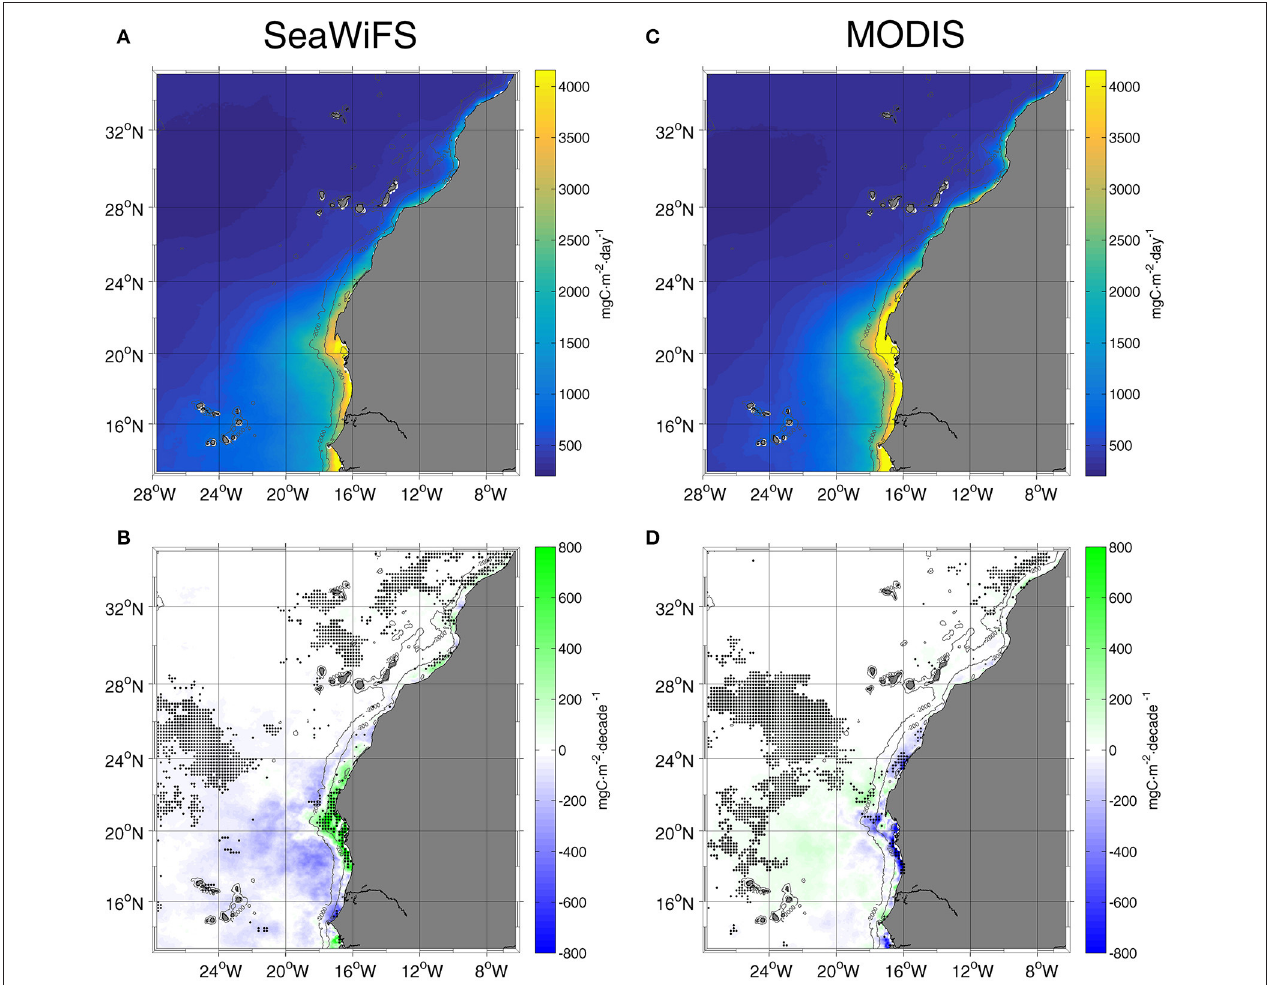
FIGURE 4 | Mean Eppley-VGPM (A,C) and Eppley-VGPM trend (B,D) maps for SeaWiFS (1998–2007, left column) and MODIS (2003–2015, right column) datasets. In (B,D) black dots correspond to significant trends ( p < 0.05). 200 and 2000m isobaths are represented by contour